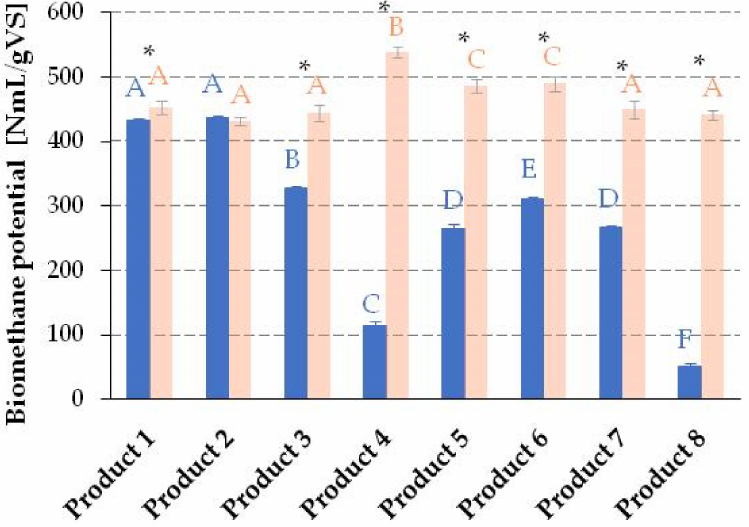
Figure 3. Average biomethane potential (BMP) (blue columns) and theoretical methane production (ThBMP) (orange columns) of the biodegradable plastics used in the study on the 30th day of the experiment. Different letters indicate significant differences in BMP (blue) and ThBMP (orange) between the investigated products ( p < 0.05). Asterisks (*) indicate significant differences between the BMP and ThBMP for the given product (Product 1: p = 0.021, Products 3–8: p < 0.001).